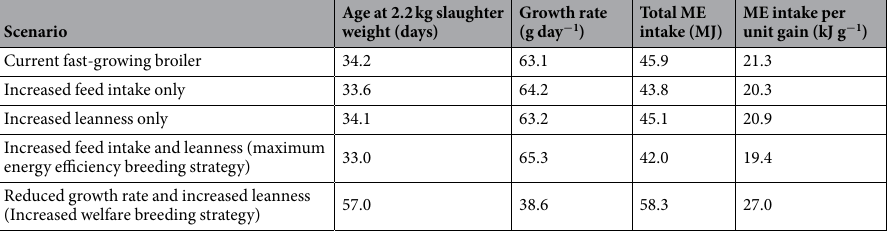
Table 1. The effects of changing different processes of energy flow on the growth rate, total metabolizable energy (ME) intake and ME intake per unit mass of gain of a broiler grown to 2.2 kg. When changed, the feed intake and leanness are increased to their apparent biological limits.